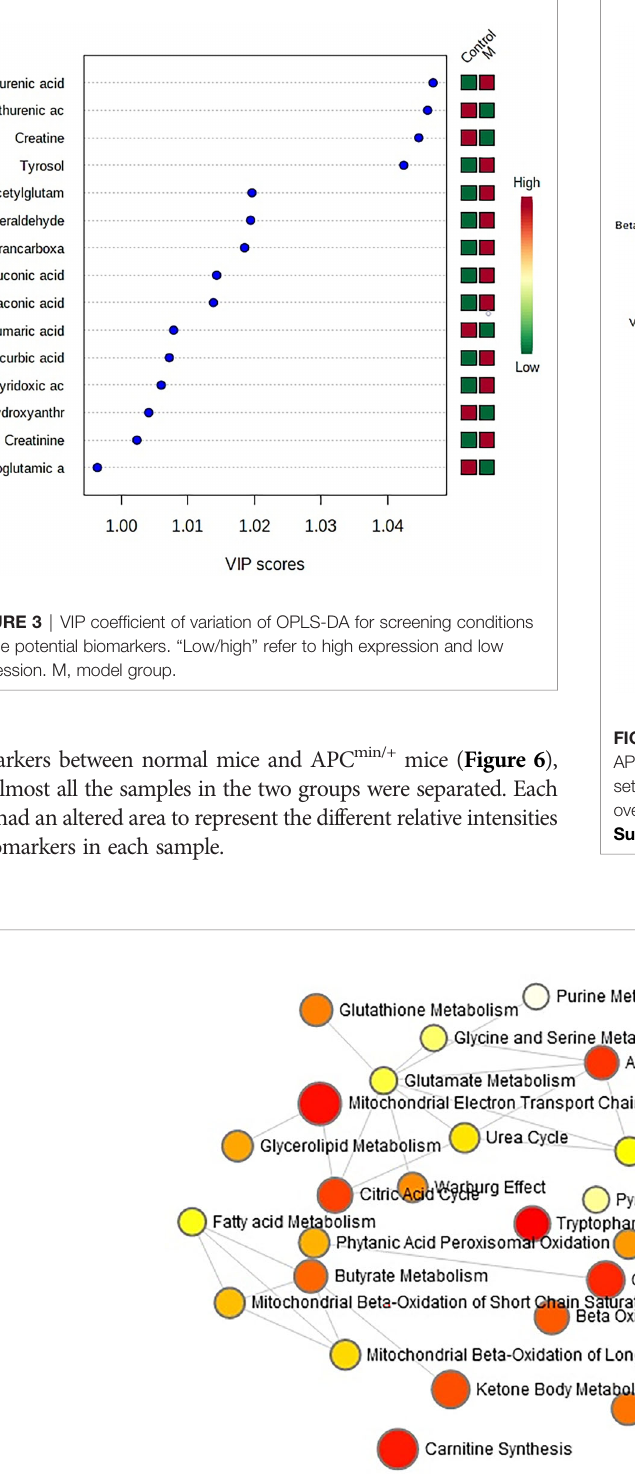
FIGURE 4 | The network pathways analysis in the APCmin/+ mice by the MetaboAnalyst 4.0 tool. The module of ‘ Metabolic pathway analysis ’ was applied in the present study to explore the associated metabolic pathways for all the differentiated metabolites. Each circle indicates a signi fi cantly altered cluster of metabolites.